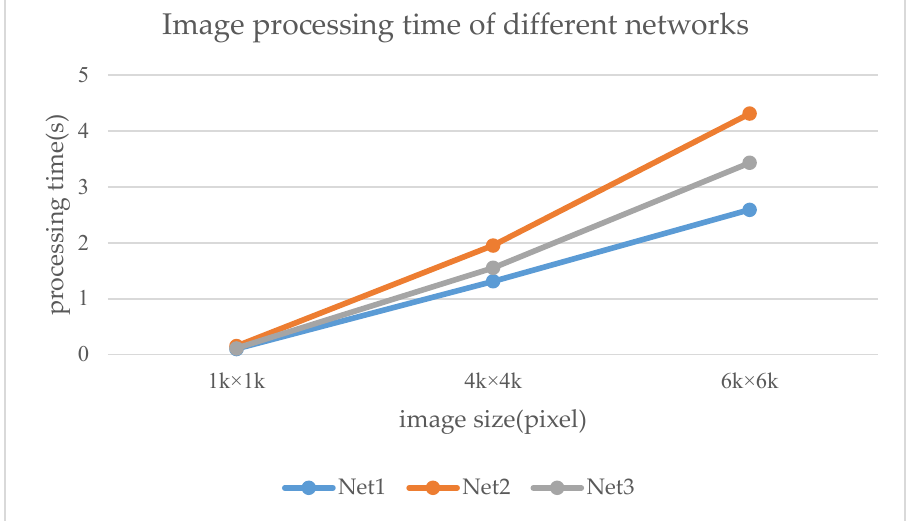
Figure 14. Image processing times of different networks.